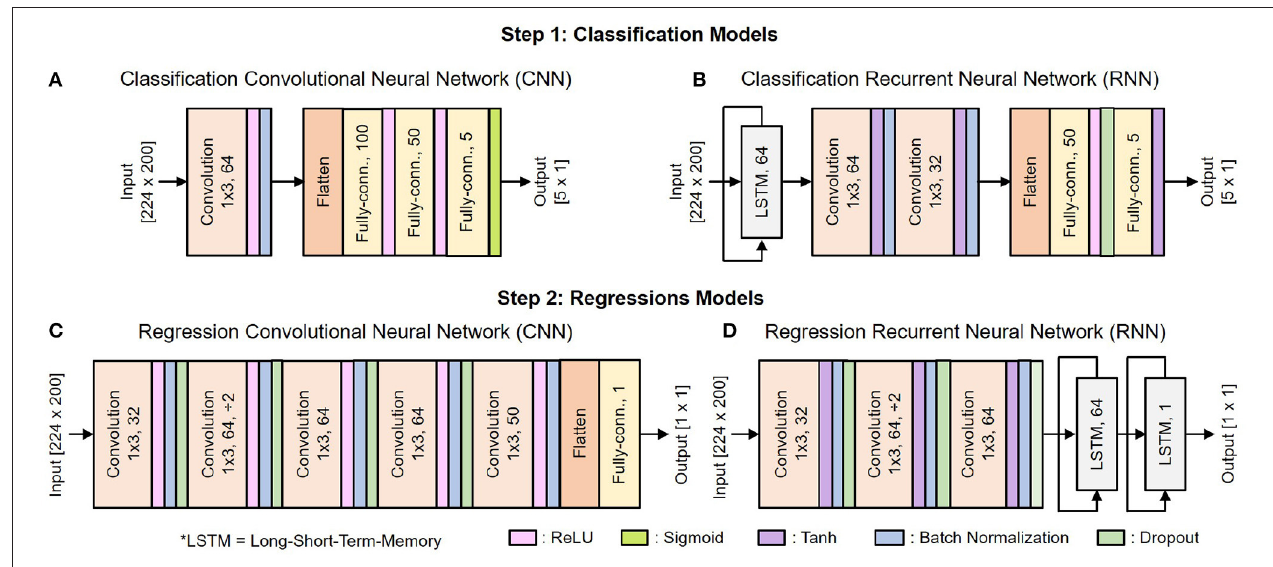
FIGURE 6 | Architecture of the deep learning models: (A) CNN for classification, (B) RNN for classification, (C) CNN for regression, (D) RNN for